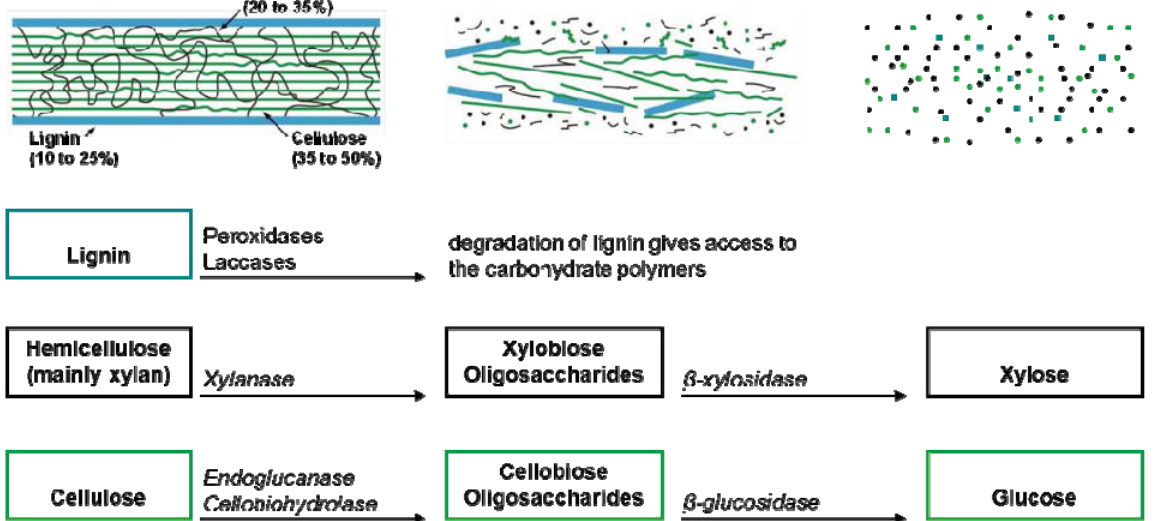
Figure 2. Schematic overview of the composition of secondary plant-cell walls of woody tissue and grasses, which are composed predominantly of lignin, hemicellulose and cellulose. Some of the most important enzymes involved in the degradation of the main polysaccharides into disaccharides and oligosaccharides, which are further degraded to soluble monosaccharides that can be assimilated, are